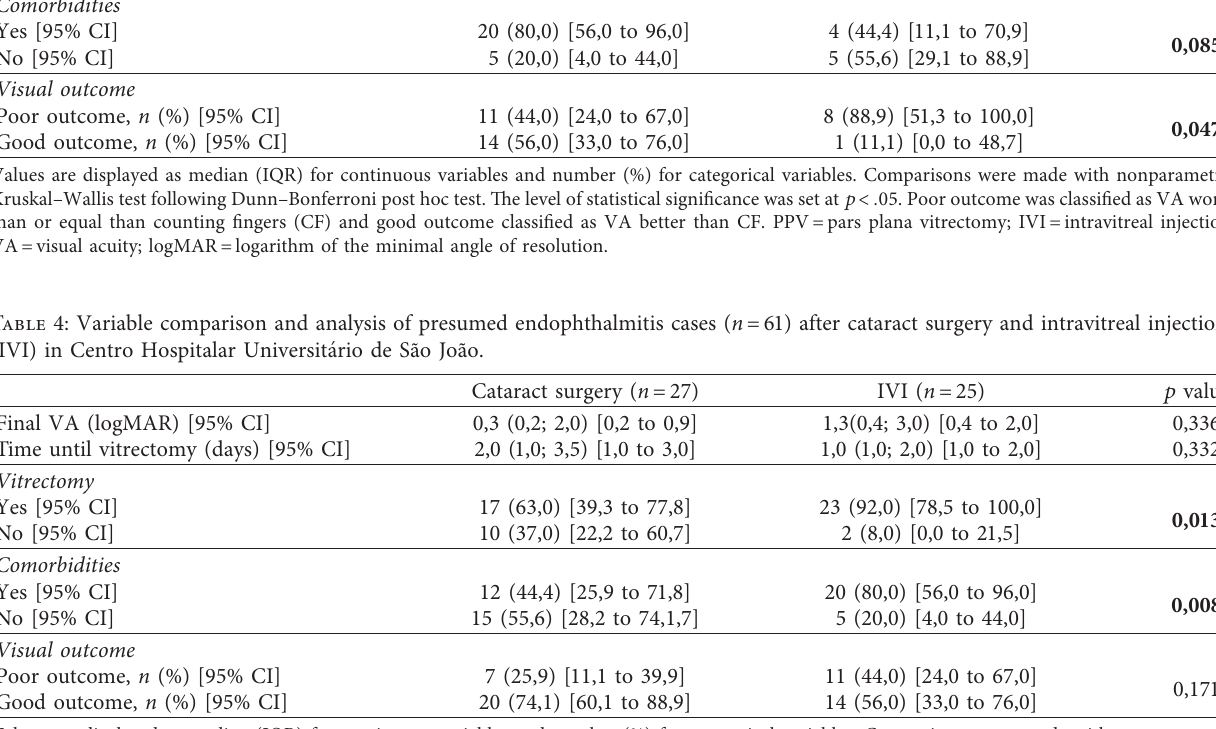
Poor outcome, n (%) [95% CI] Values are displayed as median (IQR) for continuous variables and number (%) for categorical variables. Comparisons were made with nonparametric Kruskal–Wallis test following Dunn–Bonferroni post hoc tests. The level of statistical significance was set at p < . 05. Poor outcome was classified as VA worse than or equal than counting fingers (CF) and good outcome classified as VA better than CF. PPV � pars plana vitrectomy; IVI � intravitreal injection; VA � visual acuity; logMAR � logarithm of the minimal angle of